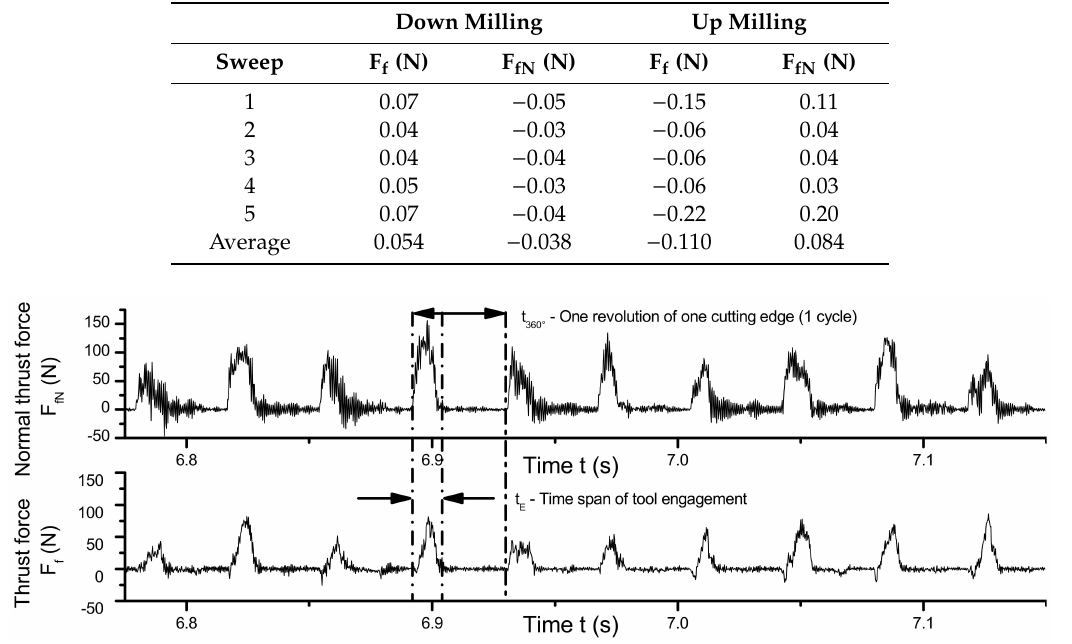
Figure 15. Example of the force signals measured during milling test of cellular stainless steel (1.4841, 45 ppi, f z = 1 mm, a e = 5 mm, v c = 50 m / min). The angle of engagement in peripheral milling